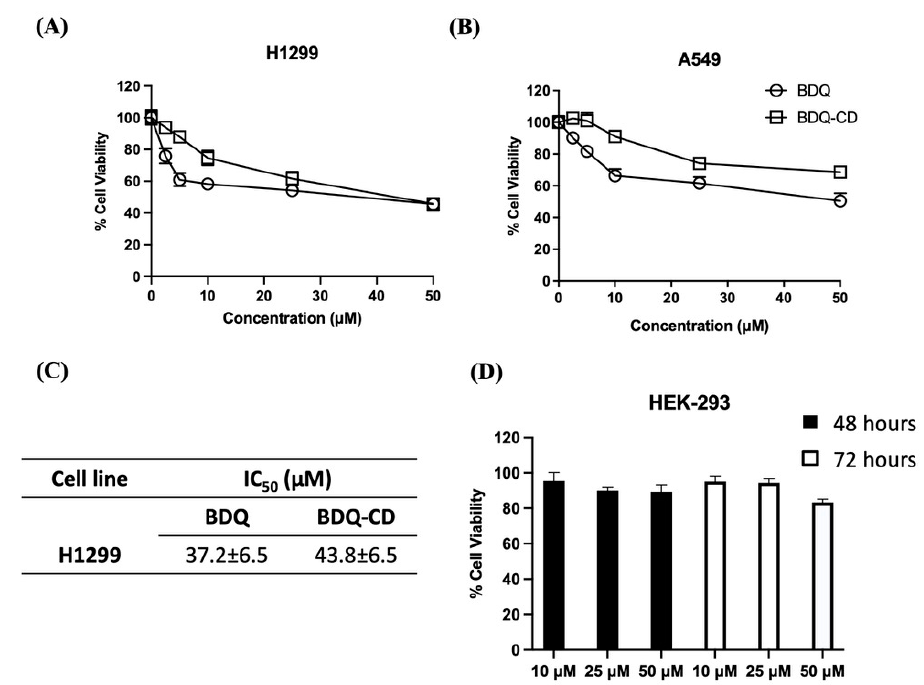
Figure 9. Cell viability results comparing BDQ and BDQ-CD on two different NSCLC cell lines. ( A ) H1299 and ( B ) A549. Cells were treated with different concentrations of each treatment for 72 h and cell viability was measured using MTT assay. Cells grown in media were considered as control (100%). ( C ) Table representing IC 50 values for BDQ-CD complex. Data represent mean ± SD with n = 6. ( D ) Safety studies: Cytotoxicity studies on HEK-293 cell line after treatment with SBE- β -CD. Cells were incubated with equivalent amounts of SBE- β -CD to 10, 25, and 50 µ M of BDQ-CD for 48 and 72 h. Data represent mean ± SD ( n =